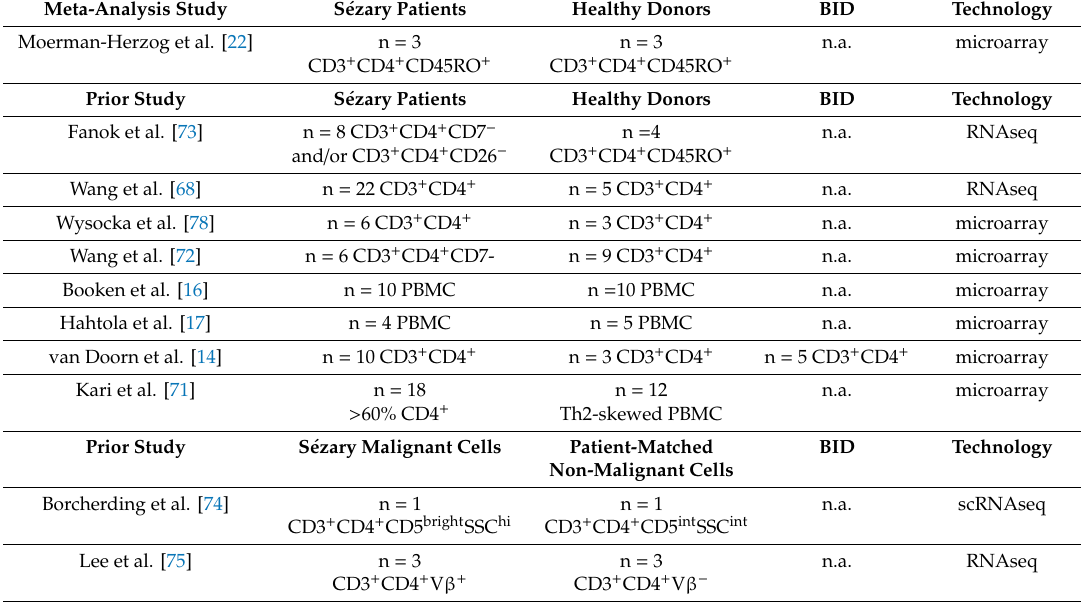
Table 3. SS transcriptomic profiling studies included in Figure